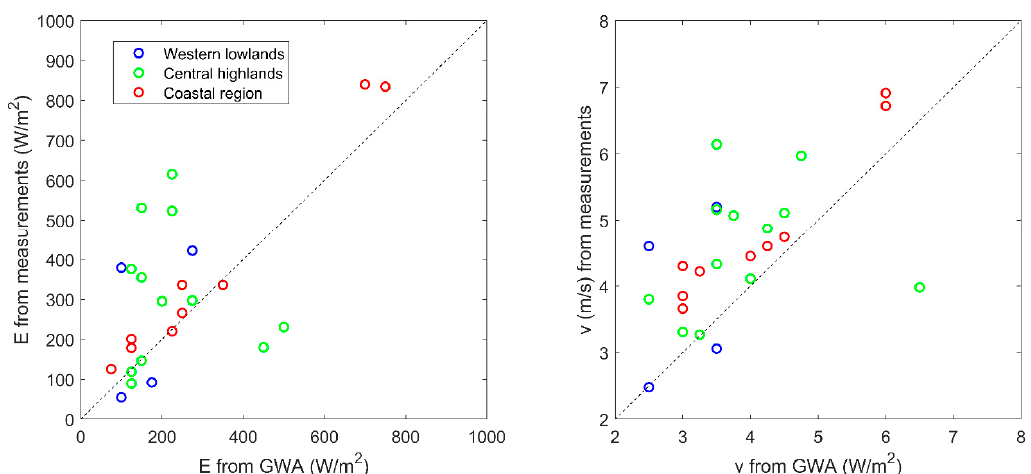
Figure 2. The relation between values calculated from measurements and GWA values. Note that the wind power density E is for 100 m above ground and the wind speed is for 10 m above ground.